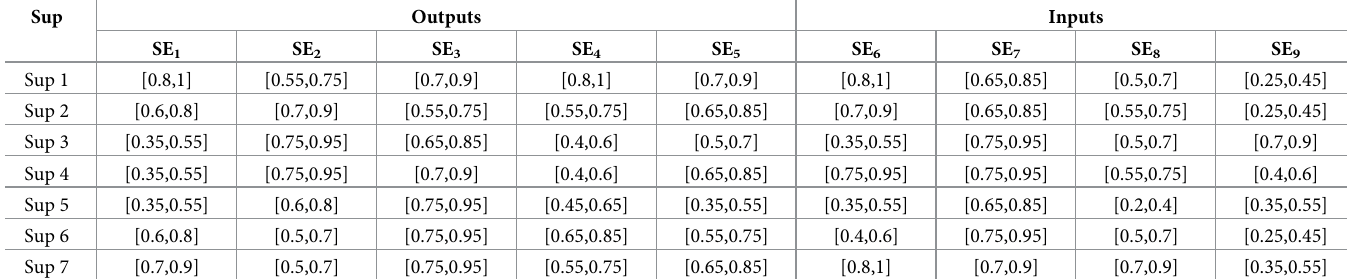
Table 8. Interval ratings of suppliers with respect to